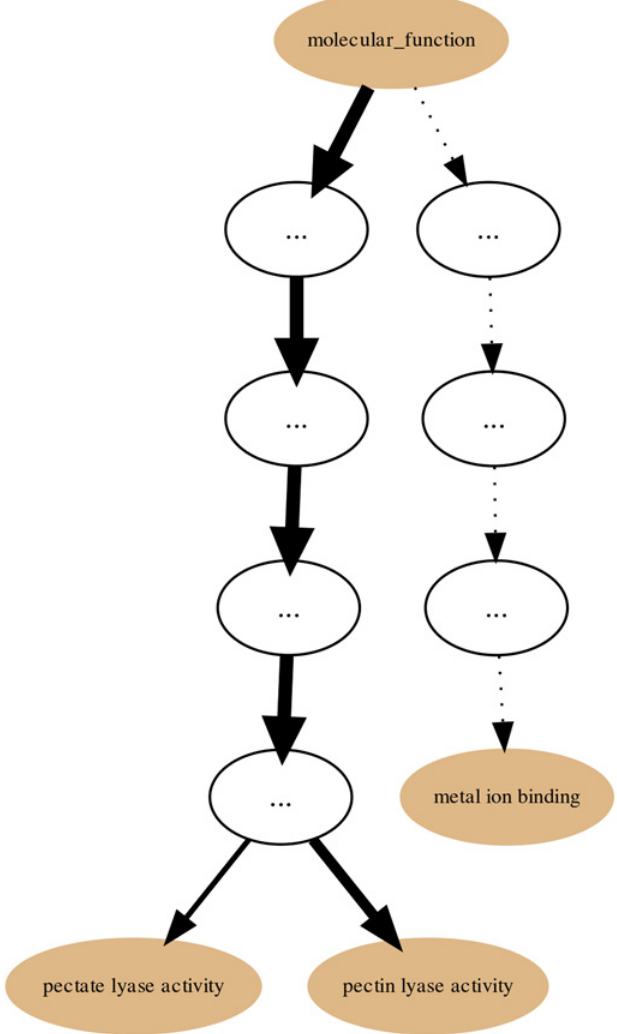
Fig 7. PL1 Set non-IEA annotation graph for the GO molecular function sub-ontology. Annotation graph subsuming the PL1 (within the CAZy Collection) Set GO molecular function sub-ontology annotations without electronic annotations